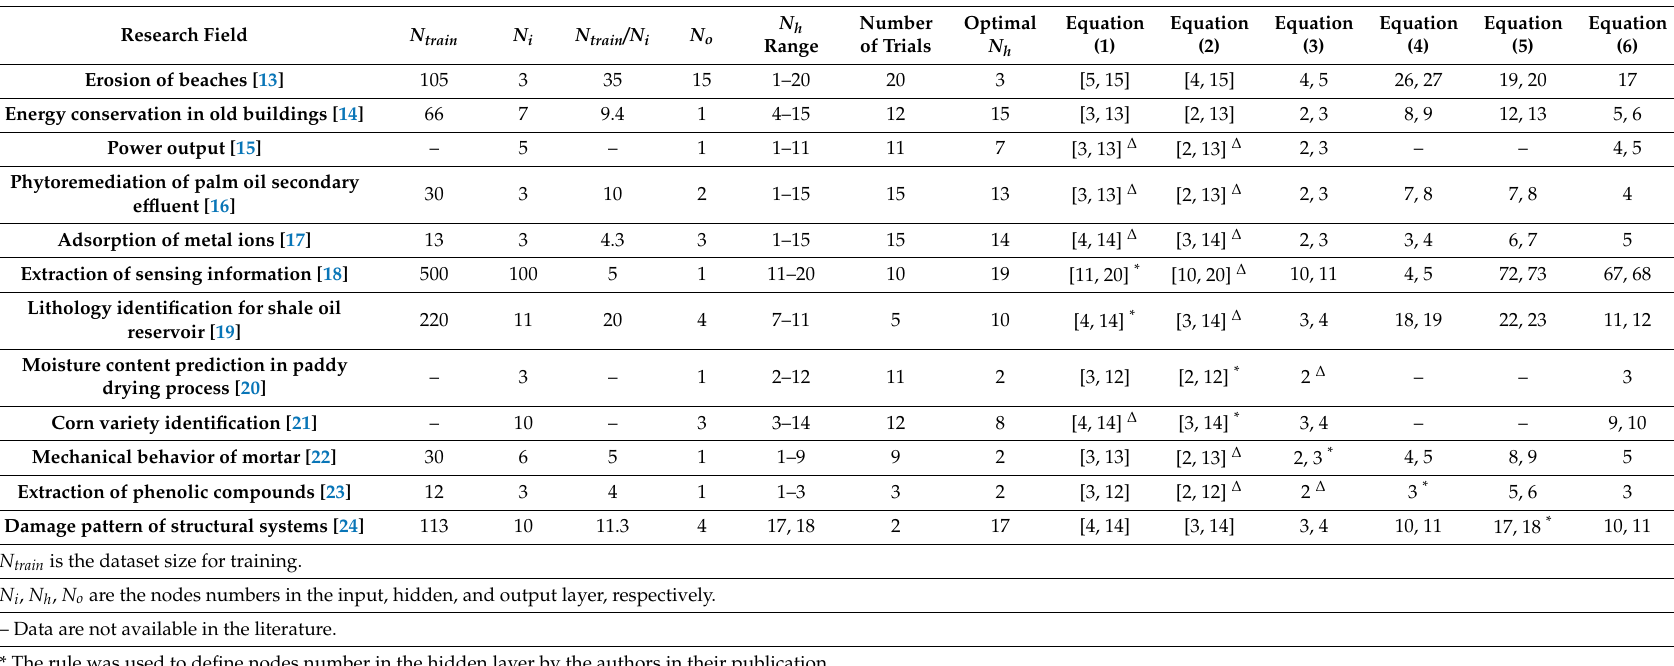
Table 1. Literature study of rules to define the node number in the hidden